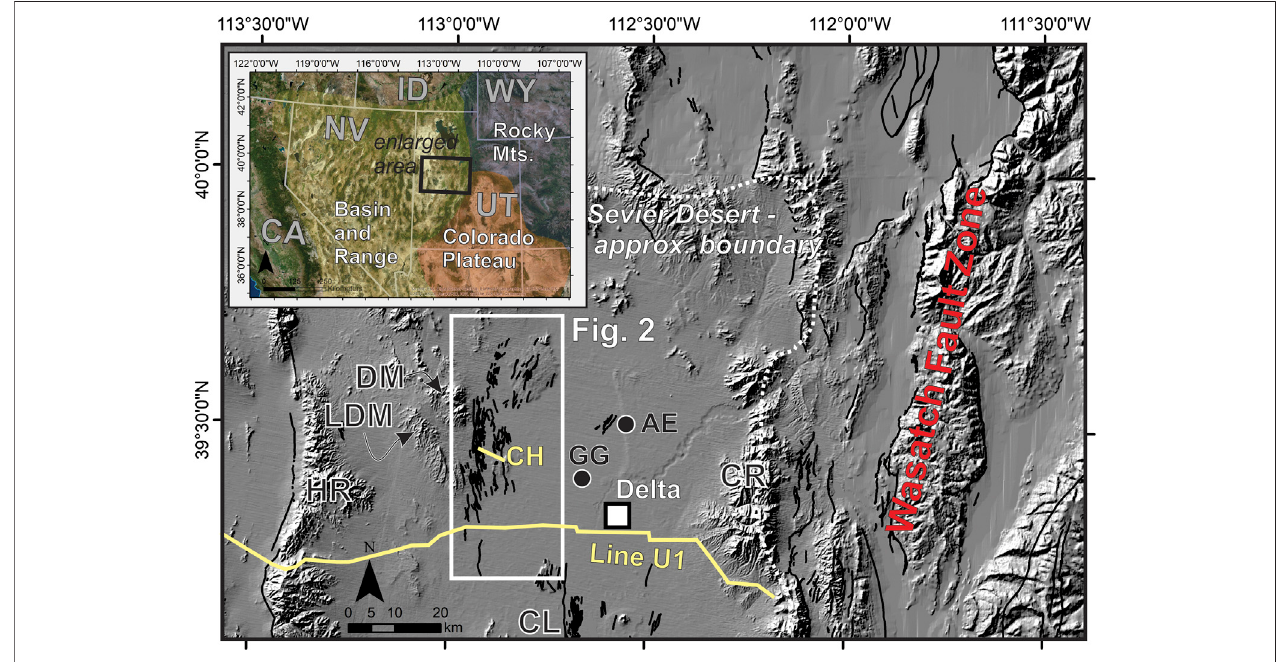
FIGURE1| Location ofthe Drum Mountains and Crater Bench fault zones within theSevier Desert ofcentral Utah(UT), USA. TheSevier Desert ispositioned in the eastern-most Basin and Range province (inset), where Quaternary normal faults (black lines) accommodate extension. The Wasatch fault zone accommodates the majority of the c. 4 mm yr − 1 westward motion of the Basin and Range relative to the Colorado Plateau from continuous GPS measurements. Extension rates of Quaternary faults near Delta, Utah, are < 1 mm yr − 1 and < 0.1 mm yr − 1 to the west in the House Range (HR) (Stahl et al., 2020). Seismic lines of Allmendinger et al. (1983) and Croneand Harding(1984),referred tointext, are shown as “ LineU1 ” and “ CH ” , respectively. DM, DrumMountains;LDM, Little Drum Mountains; HR, House Range; CR, Canyon Range; CL, Clear Lake fault zone; AE, Argonaut Energy well; GG, Gulf Gronning well.